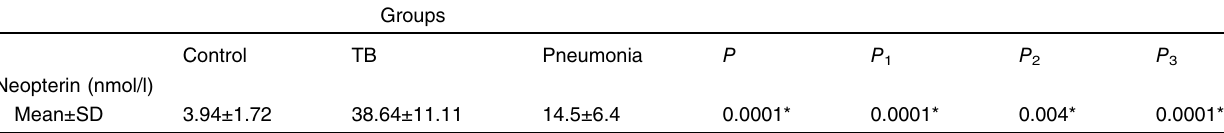
Table 3 Serum neopterin levels in the three studied groups